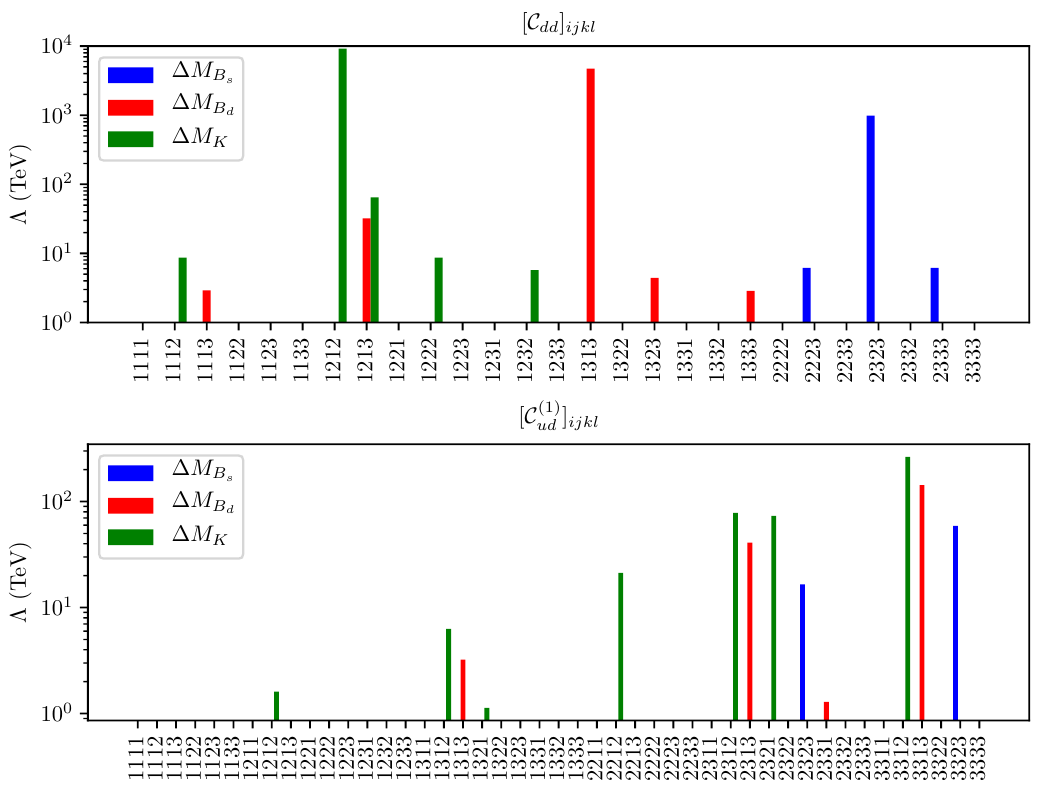
(cid:2) (cid:3) c = 10 (upper) and dd ijkl (cid:2) (cid:3) M ij / (∆ M ij ) exp for B s (blue), B d (red) and K 0 (green), 12 BSM